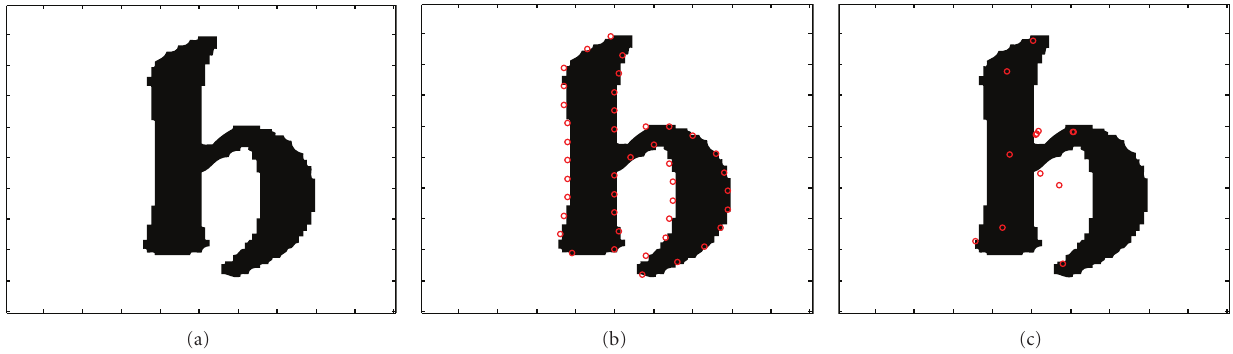
Figure 12: (a) Interest points detected from the binary image of letter “h” by (b) the proposed algorithm and (c) the SIFT algorithm.